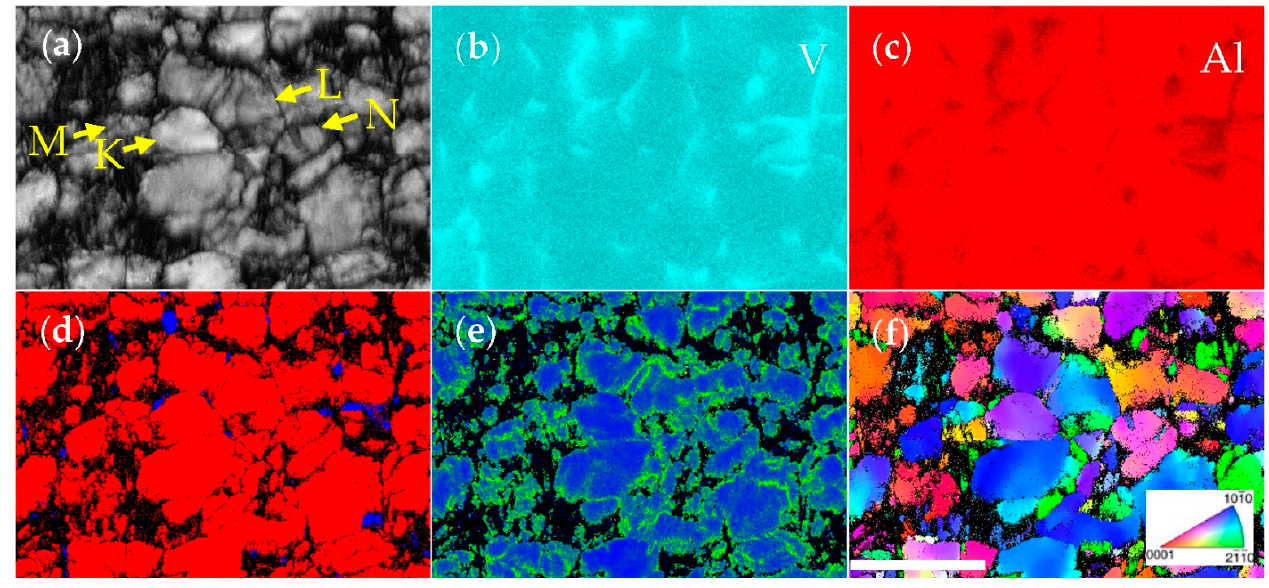
Figure 3. SEM images of the Ti64GL sample after its SHPB test (strain rate 2200 s − 1 ) within conven- tional EBSD and EDS analyses. The presented area was located inside the zone D (Figure 1a). The Pattern Quality Map (PQM) ( a ); elemental maps V and Al ( b ) and ( c ) correspondingly; phase map image ( d ), where α -phase is shown in red, β -phase in blue; Grain Misorientation Map (GMM) ( e ), the green areas are misoriented from blue on about 2–2.5 degrees; orientation map image (IPF) ( f ). The scale bar in ( f ) is 10 μ m.